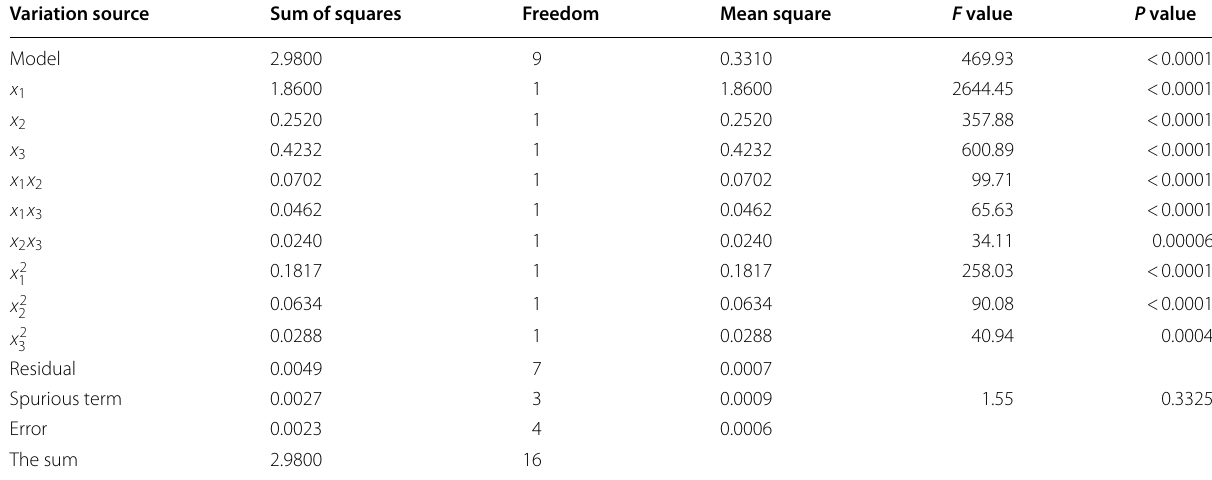
Table 5 Variance analysis of kerf depth regression model Variation